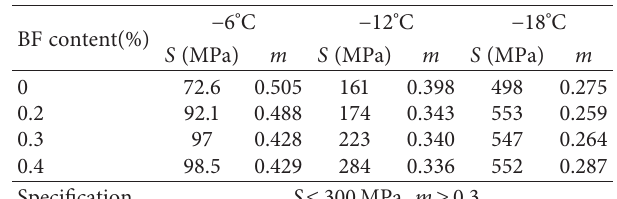
Table 6: BBR results.